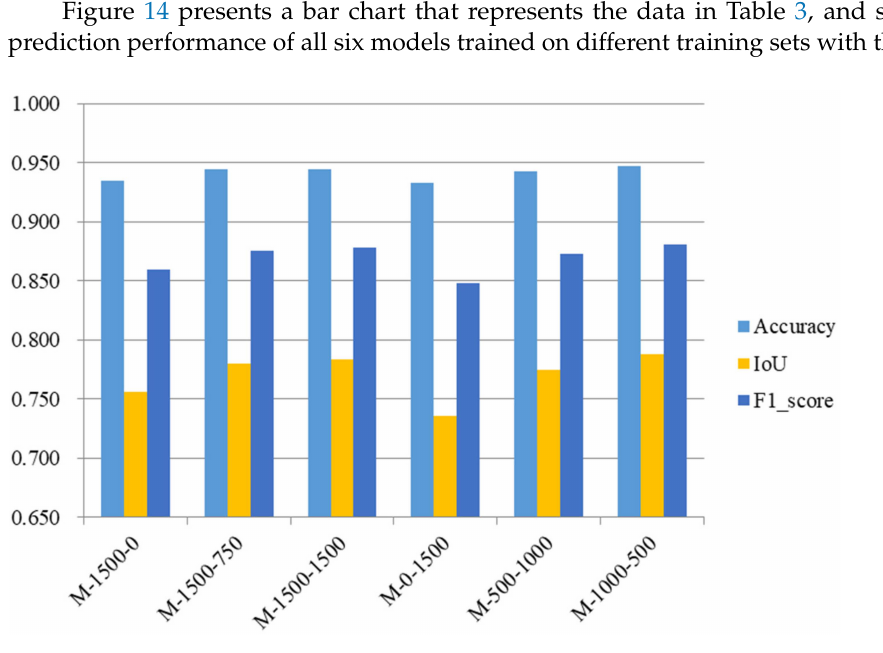
Figure 14. Prediction performance of each model.